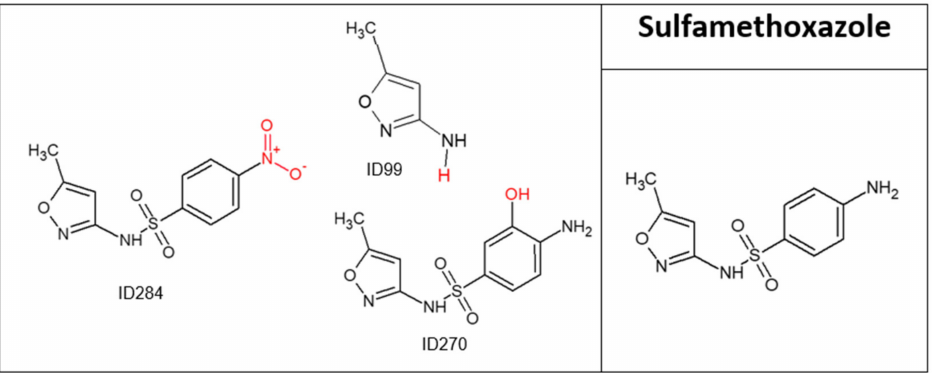
Figure 7. Sulfamethoxazole and its major transformation products. Table 7. Sulfamethoxazole transformation products’ identification